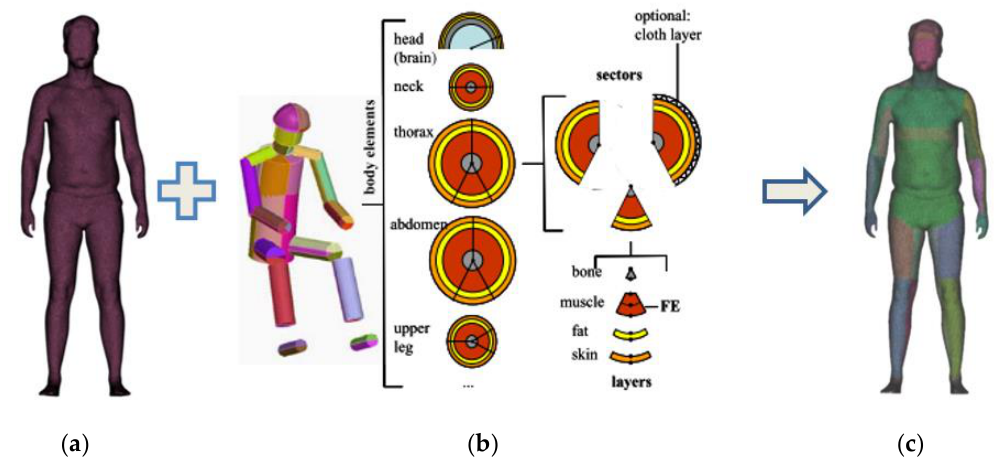
Figure 4. Development of a thermophysiological virtual model of the test person, ( a ) 3D virtual model of the test person, ( b ) Fiala Model [26], and ( c ) thermophysiological model of the test person.